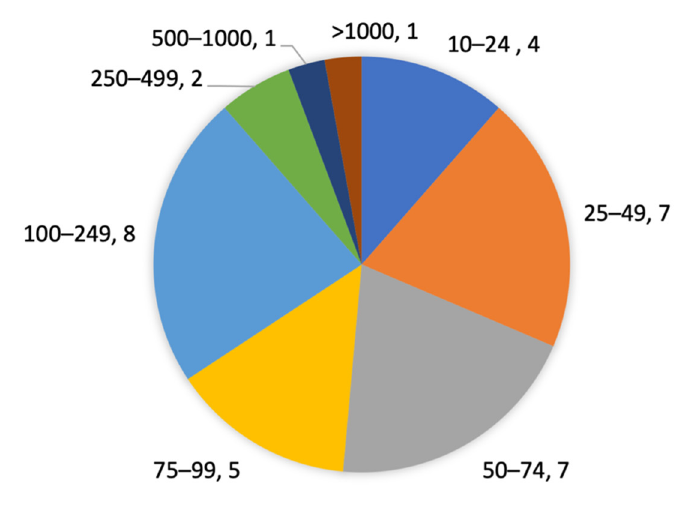
Figure 4. Distribution of study samples according to size.